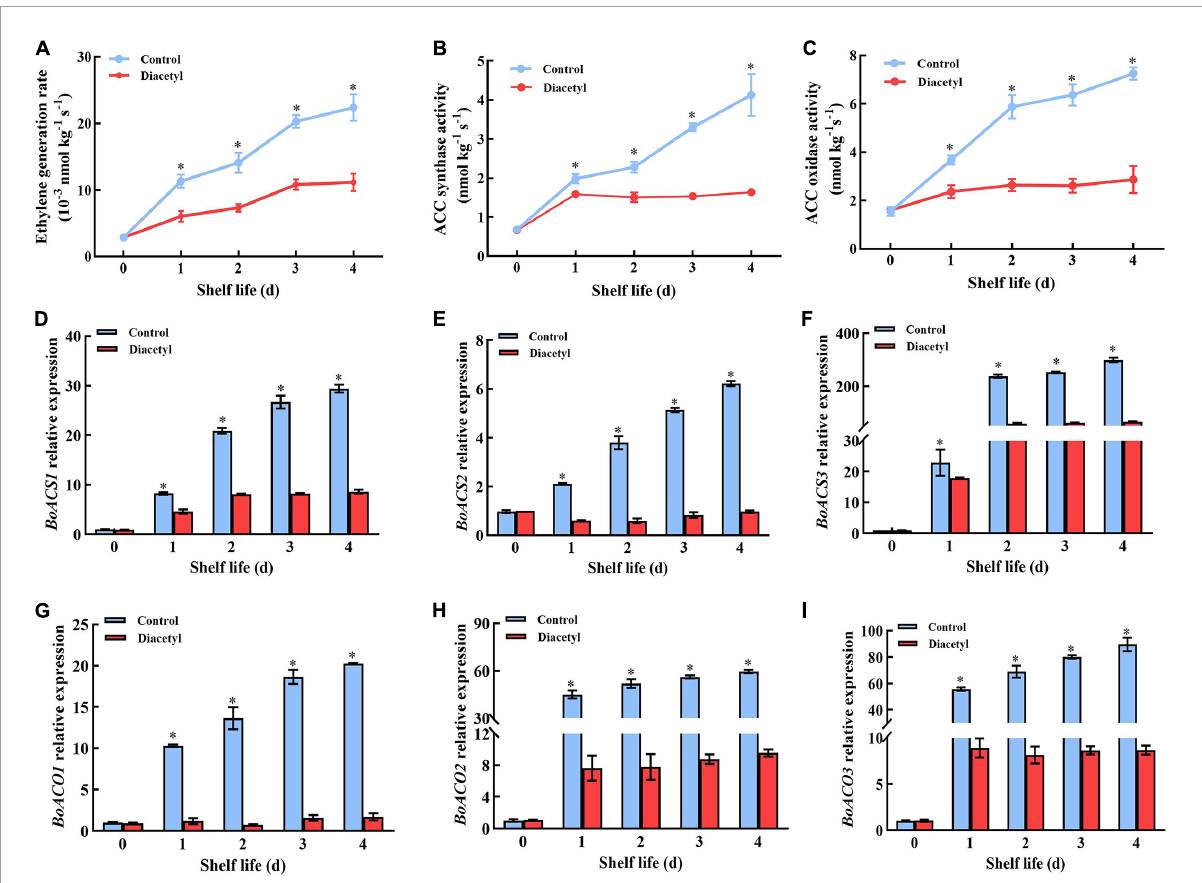
FIGURE5 Diacetyl treatment inhibited the ethylene generation of broccoli florets during shelf life. Ethylene generation rate (A), ACS activity (B) , ACO activity (C) and the transcription levels of BoACS1 (D) , BoACS2 (E) , BoACS3 (F) , BoACO1 (G) , BoACO2 (H) , and BoACO3 (I) . Data are the average of three replicates ± SD. Asterisk ( ∗ ) indicates a significant difference among the control and diacetyl treatment groups at P <